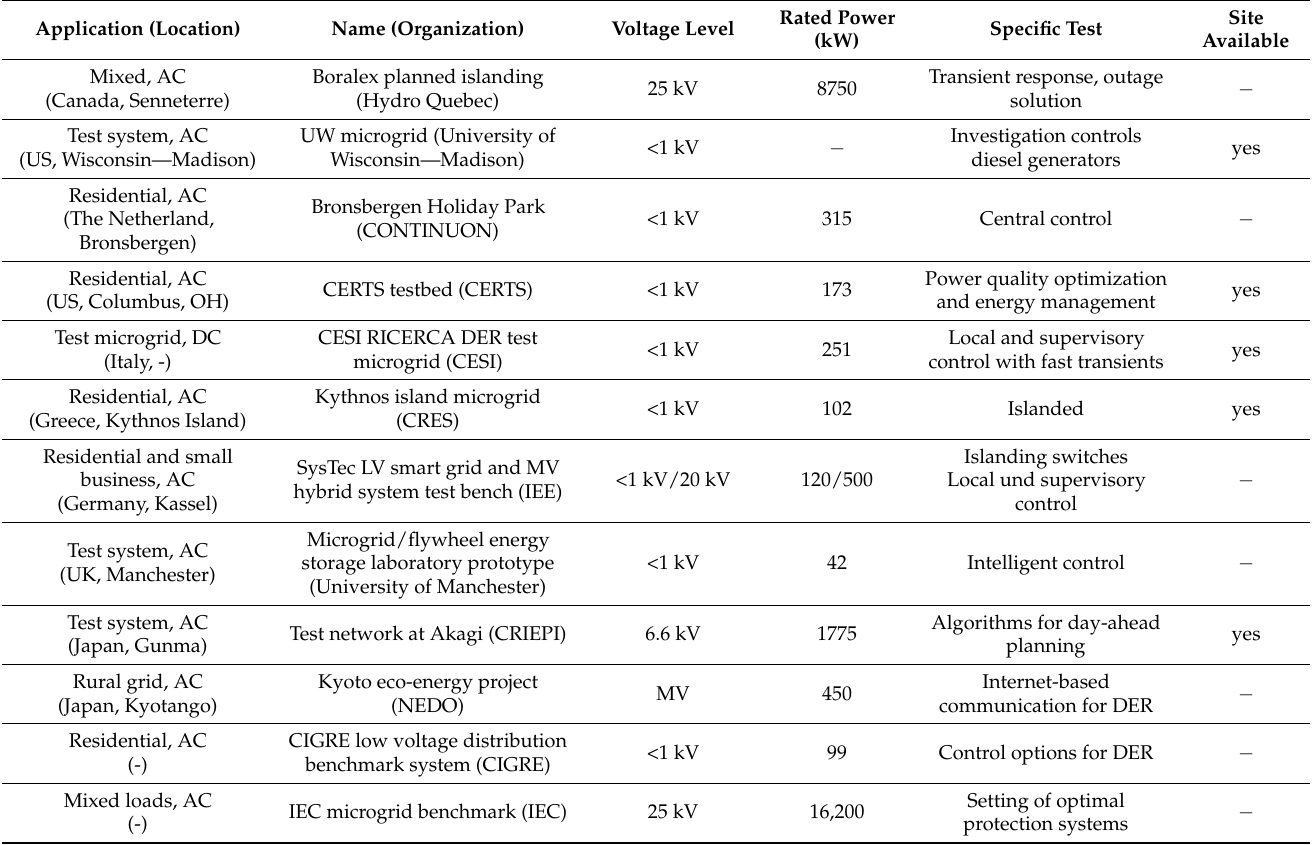
Table 2. MG systems and test-beds for MG with points of interconnection (POI) [10–12]. The information from the column “Specific Test” is extracted from the previous references. Acronyms: Centre for Renewable Energy Sources and Saving (CRES), Fraunhofer Institute for Energy Economics and Energy System Technology (IEE), Central Research Institute of Electric Power Industry (CRIEPI), and New Energy and Industrial Technology Development Organization (NEDO). Note that the sign “ − ” indicates that the information is not available for the considered